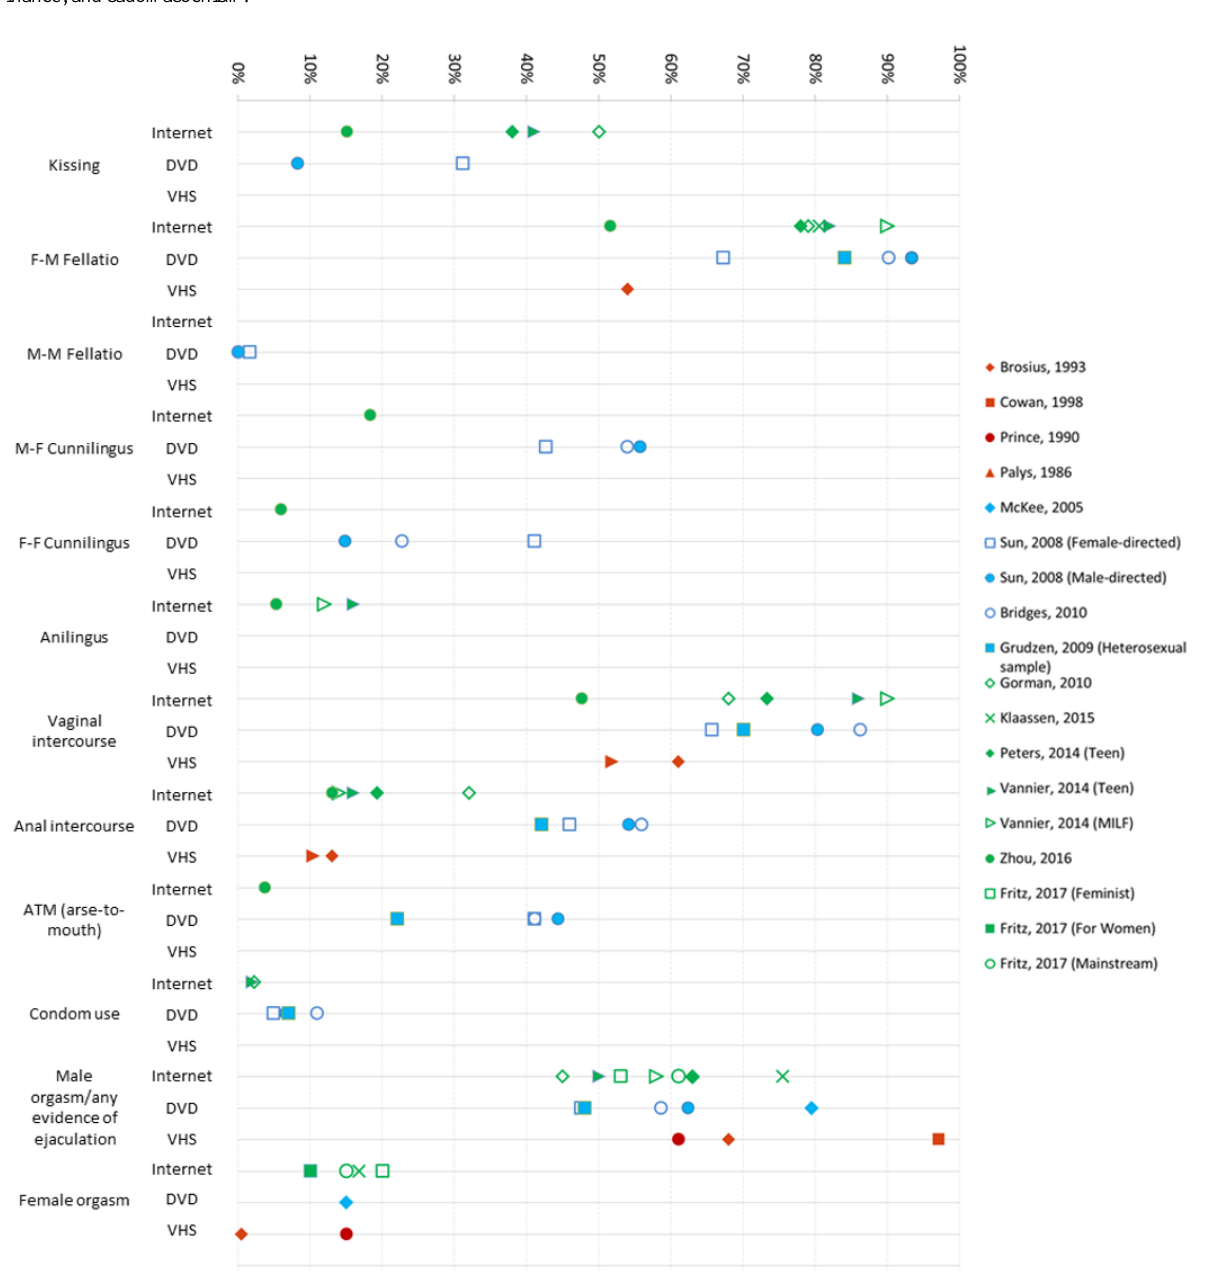
Figure 2. Percentage of general/heterosexual samples depicting key sexual behaviors, by medium of pornography (VHS, DVD, or internet-based video). Notes: Results are only presented in this graph if the study presented results by percentage of scenes or videos (ie, studies that presented results by time, mean, character excluded from graph). Paraphilias not presented due to sparse data. BDSM and group sex–related behaviors not presented due to variance in definitions and categories between studies. Ejaculation variable is presented in accordance with any estimate of ejaculation; if reporting multiple positions, the highest estimation is provided in this graph. VHS: video home system; MILF: mother(s) I’d like to fuck; BDSM: bondage, dominance, and